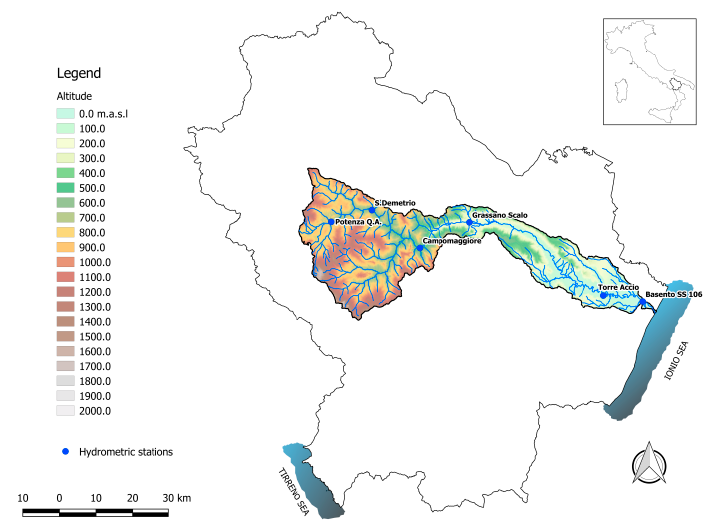
Figure 8. Sample basin (the River Basento) with hydrometric stations.